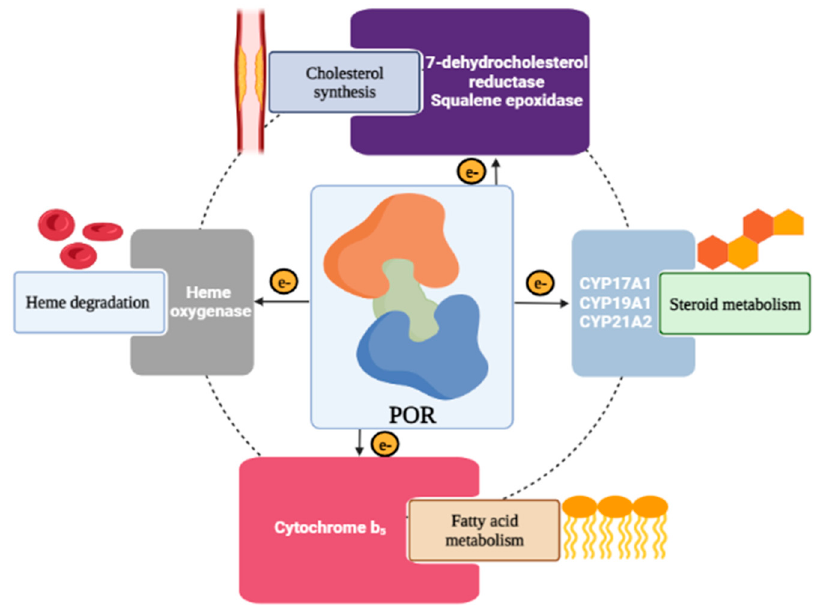
Figure 1. Role of cytochrome P450 oxidoreductase (POR). POR provides electrons to all microsomal P450 enzymes that play a crucial role in the process of metabolizing drugs, steroid hormone synthesis, and xenobiotic metabolism, as well as to other enzymes that also rely on POR to work efficiently, such as heme oxygenase, cytochrome b5, squalene monooxygenase as well as 7-dehydrocholesterol reductase.